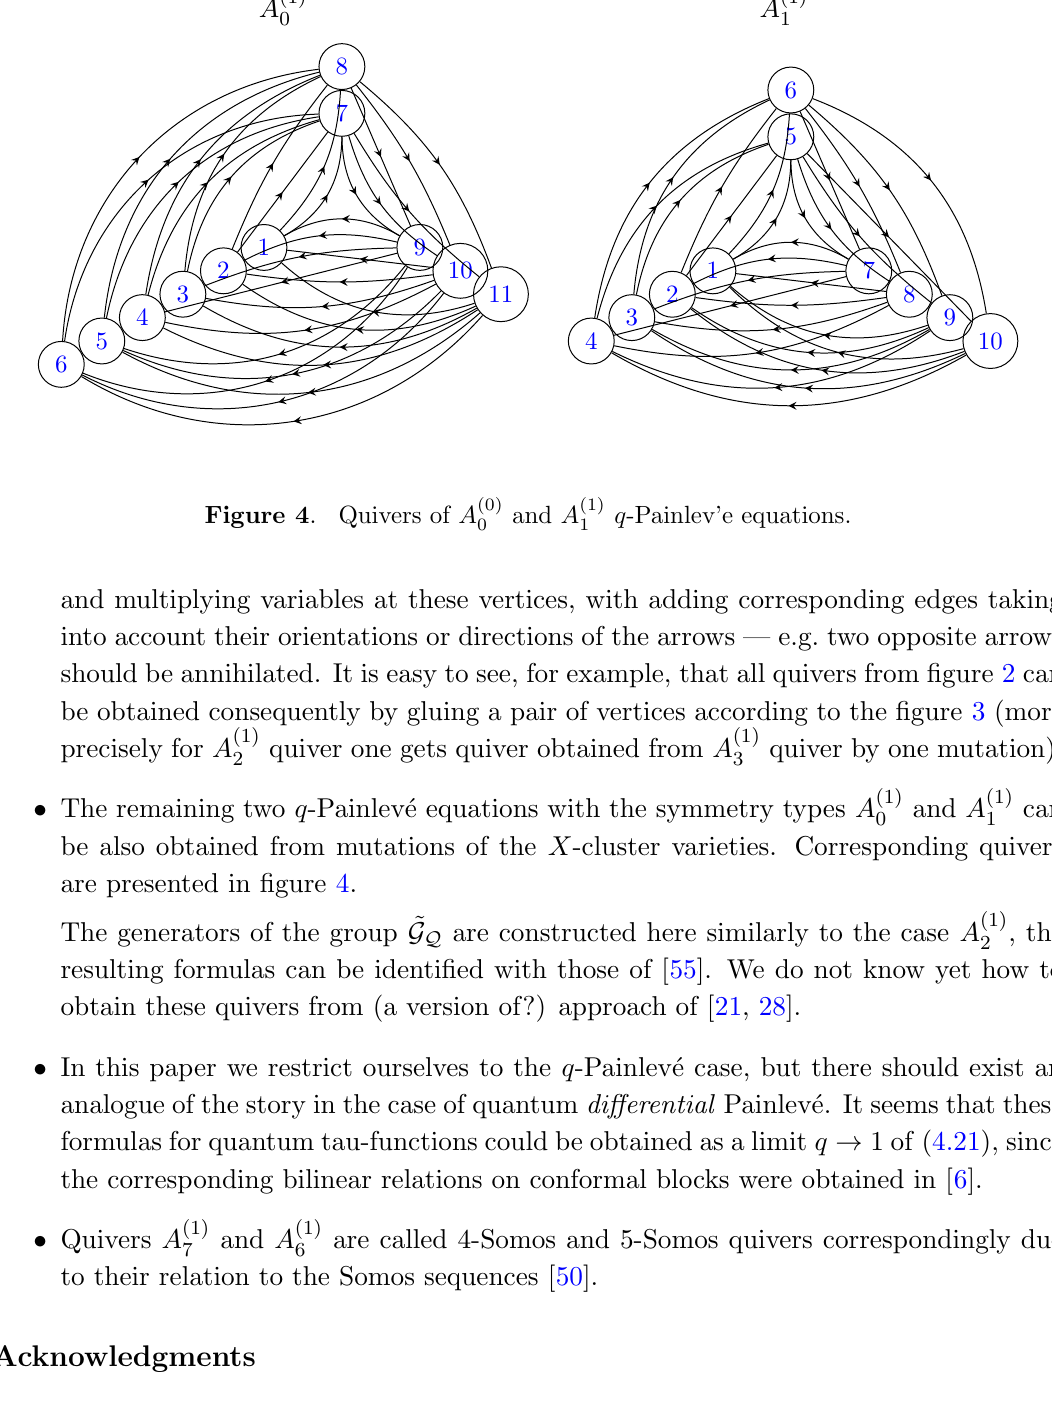
Figure 4 . Quivers of A (0)